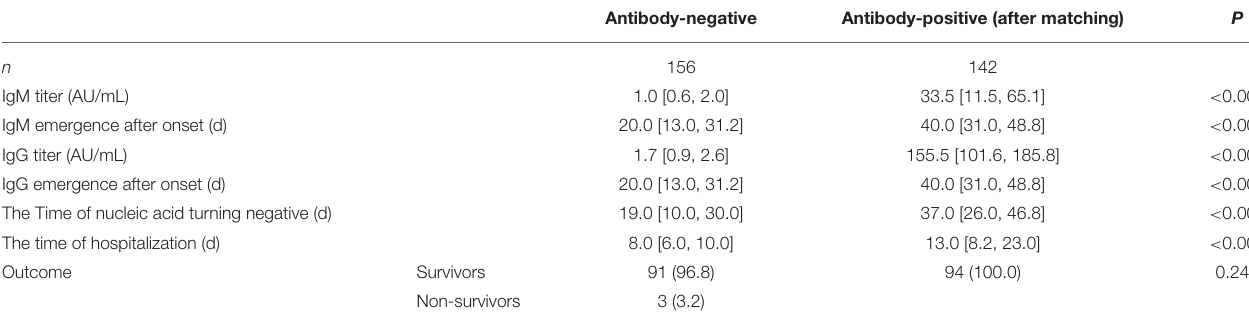
TABLE 3 | Dynamic changes of antibodies in patients with COVID-19.